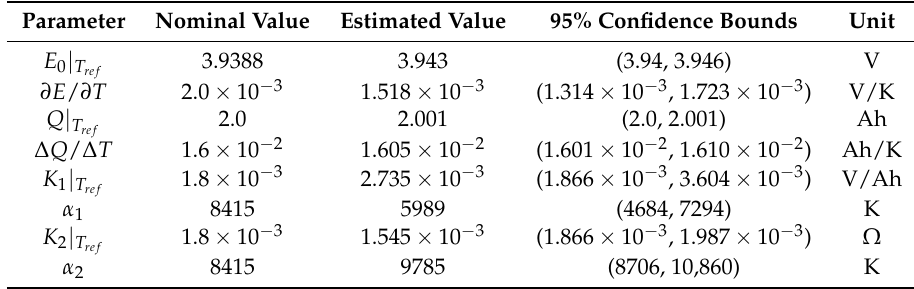
Table 6. Estimated parameters of the temperature dependency of the battery parameters during charge.